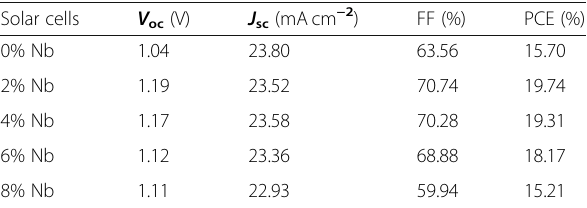
Table 1 Performance parameters of PSCs based on different Nb doping concentrations